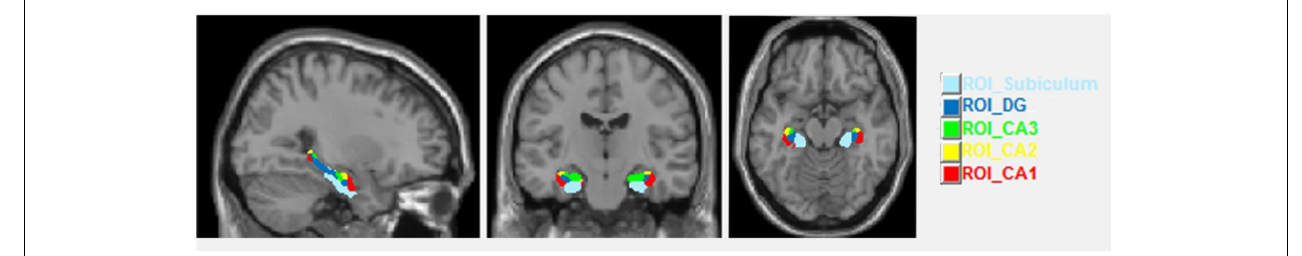
FIGURE 2 | Sagittal, coronal and axial views of the hippocampal subfields.